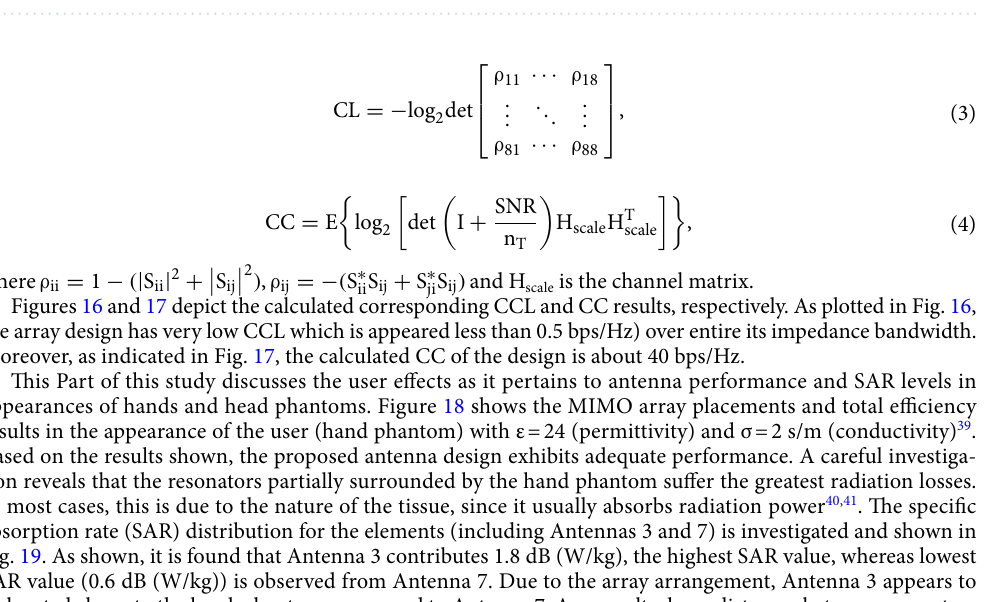
Figure 15. Calculated simulated/measured TARC results.